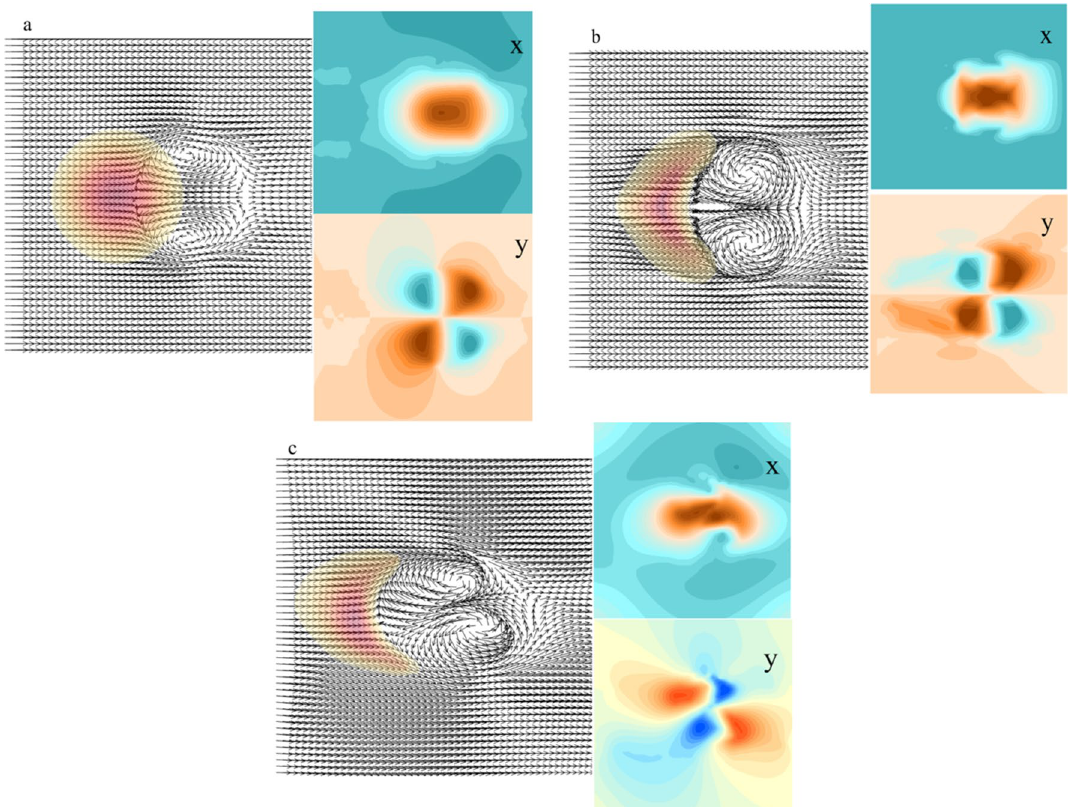
( b ); the simulated wind flow field around the asymmetric crescentic dune and the velocity component of the horizontal and vertical (x and y) directions ( c ). The map was plotted using Matlab 2014a (https ://www.mathw orks.com) and Surfer 16 (https ://www.golde nsoft